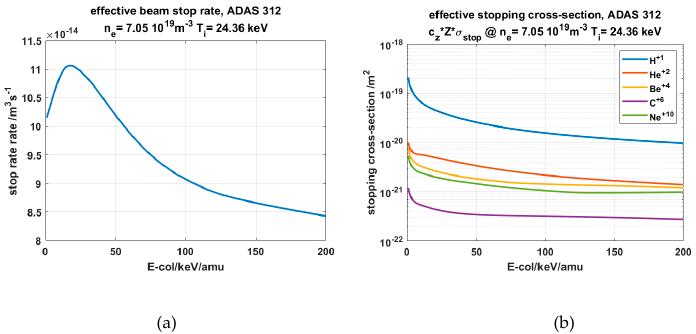
Figure 3. ( a ) Effective beam stopping rate versus collisional energy, ADAS 312(2003). ITER test case, 9MA-steady-state-at-burn scenario, He (4%), C (0.2%), Be (2%), Ne (0.3%); ( b ) effective stopping cross-sections and contributions from individual impurities. ITER test case, 9MA-steady-state-at-burn-scenario, He (4%), C (0.2%), Be (2%), Ne (0.3%). We have used here only one representative beam energy E and beam power P (as it would be the case for a negative ion source neutral beam). Figure 4a and 4b show the ITER diagnostics neutral beam (DNB) power density profiles in vertical and horizontal direction as a contour plot versus distance from duct position (plasma entry) for the low-density 9MA case